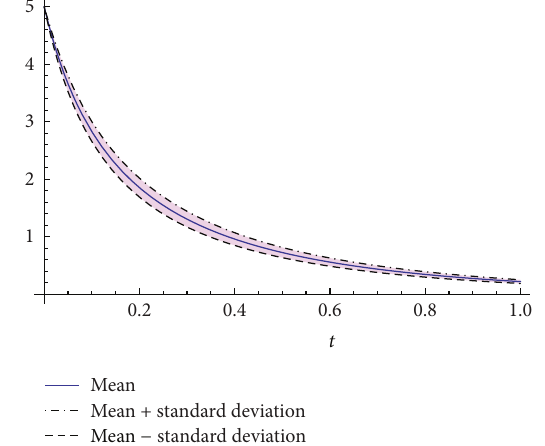
Figure 5: Approximations of the expectation (solid line) and plus/minusstandarddeviation(dashedlines)tothesolutions.p. 𝑦(𝑡) on the interval [0, 1] in Example